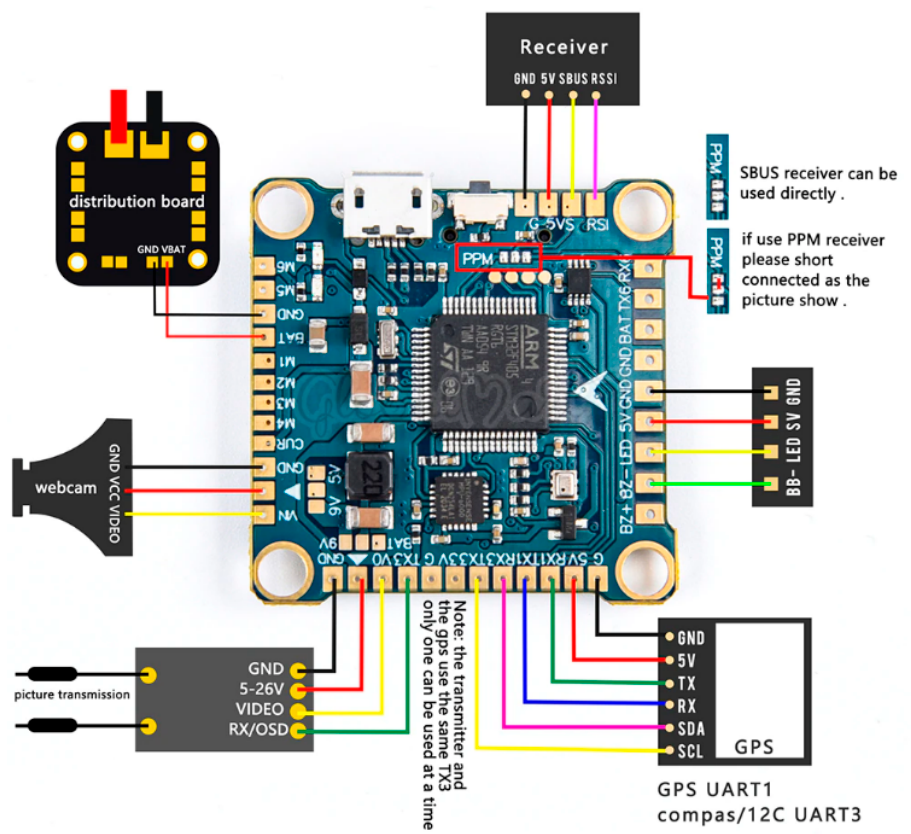
Figure 4. Layout and connectivity ports of the flight controller.